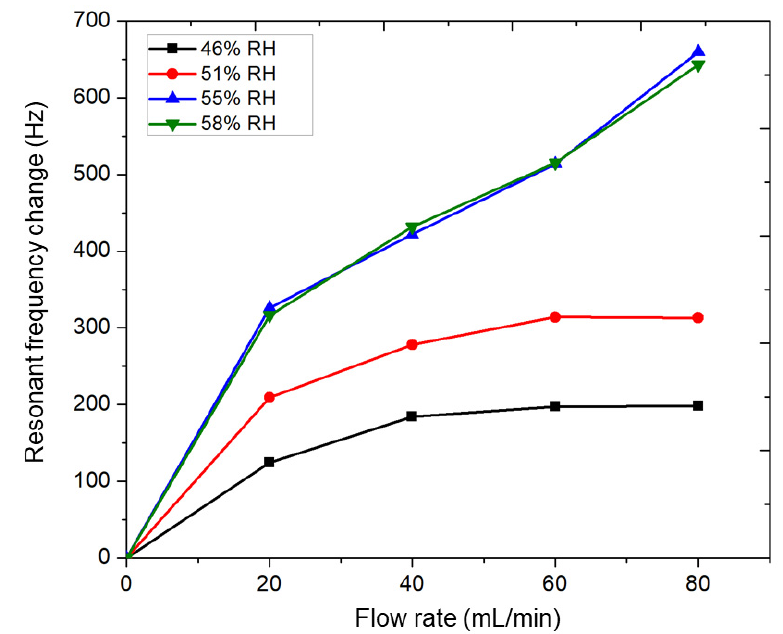
Figure 6. Resonant frequency change of the Al-doped ZnO nanorod-coated microcantilever as a function of gas flow rate for various initial relative humidity (RH) inside the chamber, i.e., 46 %, 51 %, 55 %, and 58 % RH.